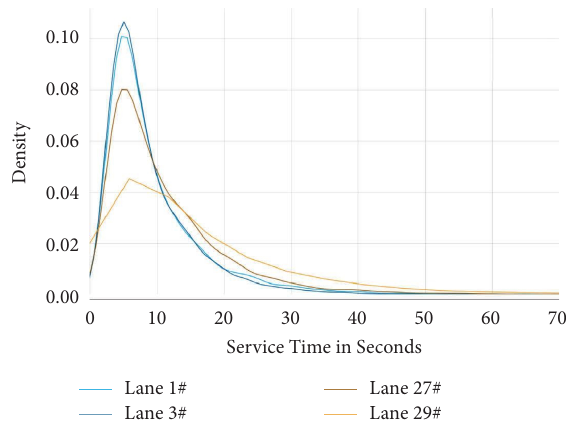
Figure 4: Density plot of service time variation for diferent ETC entrance lanes at No. 6706 toll station.